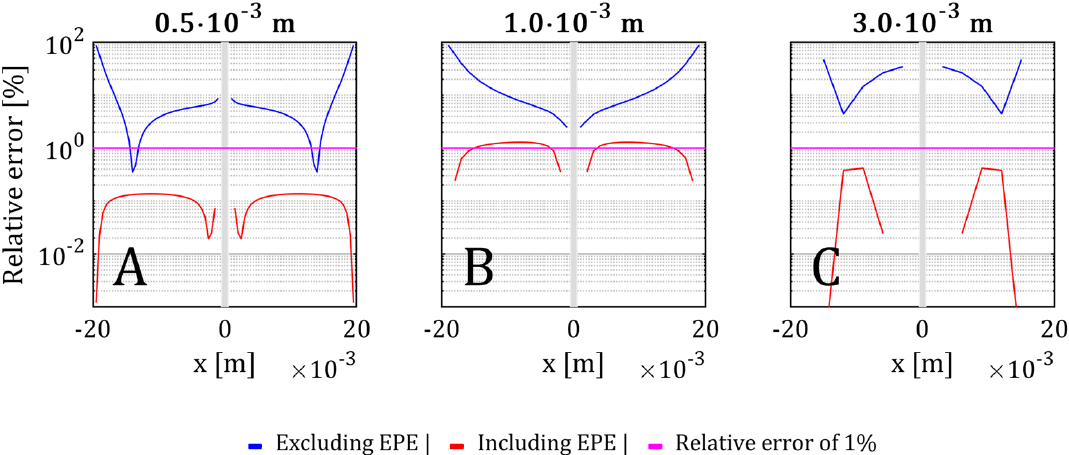
Figure 7. Relative error in the electric-potential distributions of the coaxial cable model (central grid) with respect to the analytical solution along the x-axis for the voxel sizes ( A ) 0.5 × 10 − 3 m, ( B ) 1.0 × 10 − 3 m, and ( C ) 3.0 × 10 − 3 m. The grey bar represents the location of the IRE electrode, corresponding to the inner electrode of the coaxial cable model. The discontinuity in the blue and red lines near the center reflects the local relative error approaching 0%.